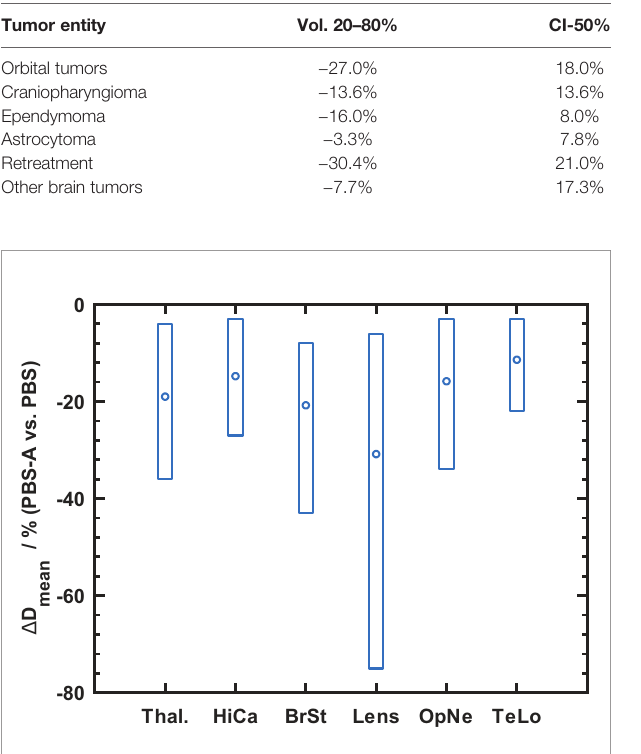
FIGURE 3 | Summary of the mean dose (D mean ) reduction for OARs using PBS-with-apertures ( “ PBS-A ” ) indicated by circles. The boxes show the full range of achieved reductions. The shown structures are Thal, thalamus; Hica, hippocampus; BrSt, brainstem; OpNe, eye lens, optical nerve; TeLo, temporal lobe.